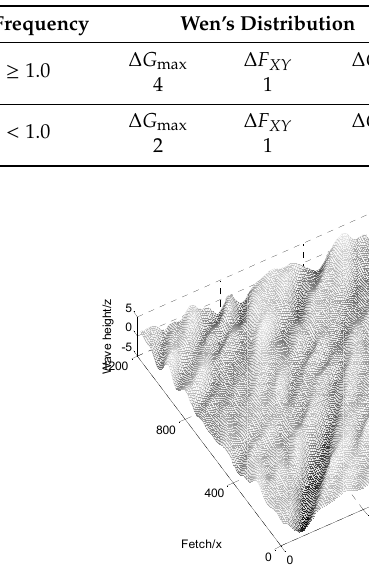
Figure 1. Simulation of 2-D sea surface by Monte Carlo method with wind speed 11 km / h, fetch 12 km and wind direction 320°.